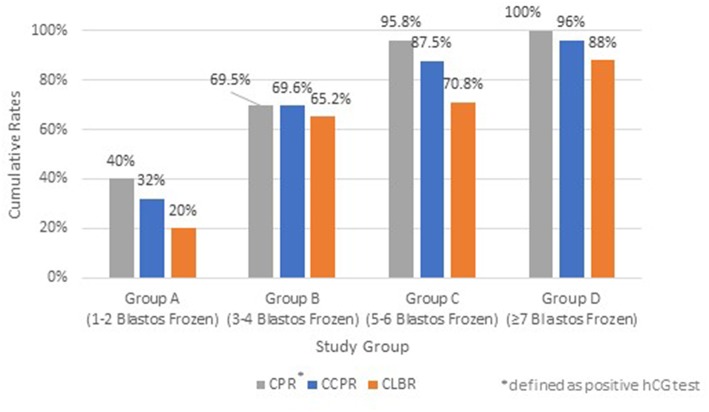
Cumulative Pregnancy Rate (CPR)*, Cumulative Clinical Pregnancy Rate (CCPR) and Cumulative Live Birth Rate (CLBR) of each study group; Group A (1–2 blastocysts frozen), Group B (3–4 blastocysts frozen), Group C (5–6 blastocysts frozen), and Group D (≥7 blastocysts frozen). *Defined as positive hCG test.